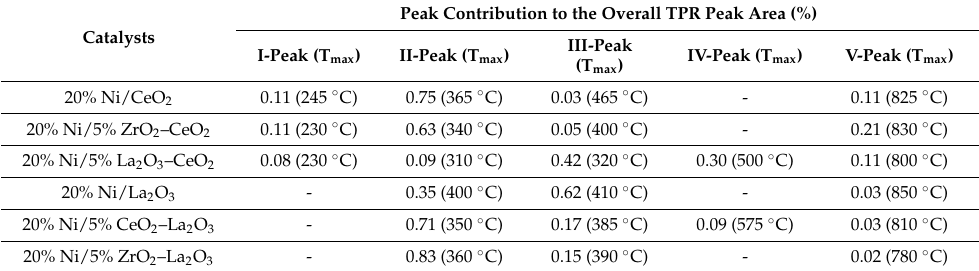
Table 4. Reduction data for the nickel-supported catalysts after calcination in an air atmosphere for 4 h at 400 ◦